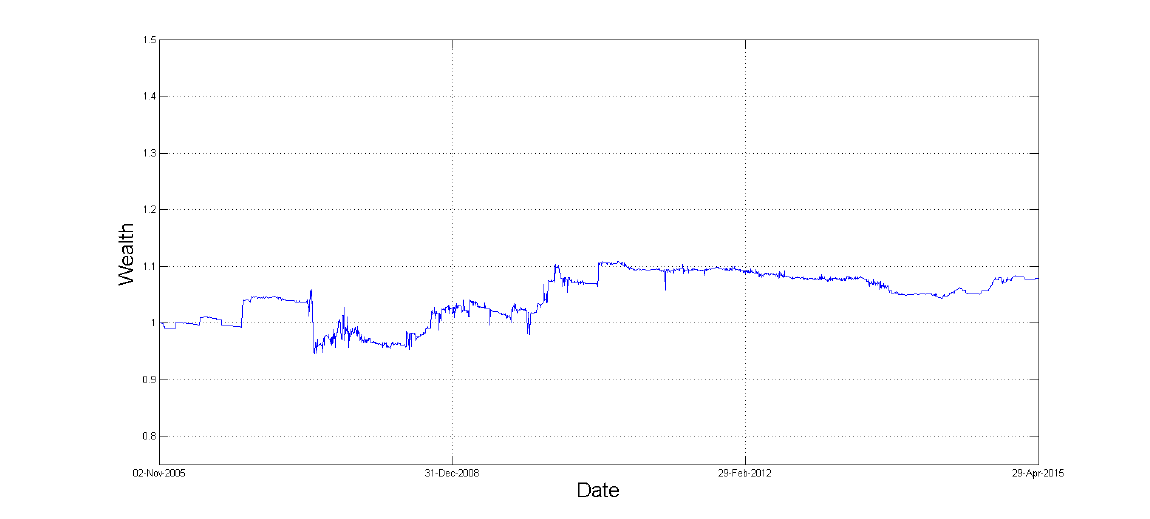
Figure 9. Ex-post wealth on Chinese bonds after second phase